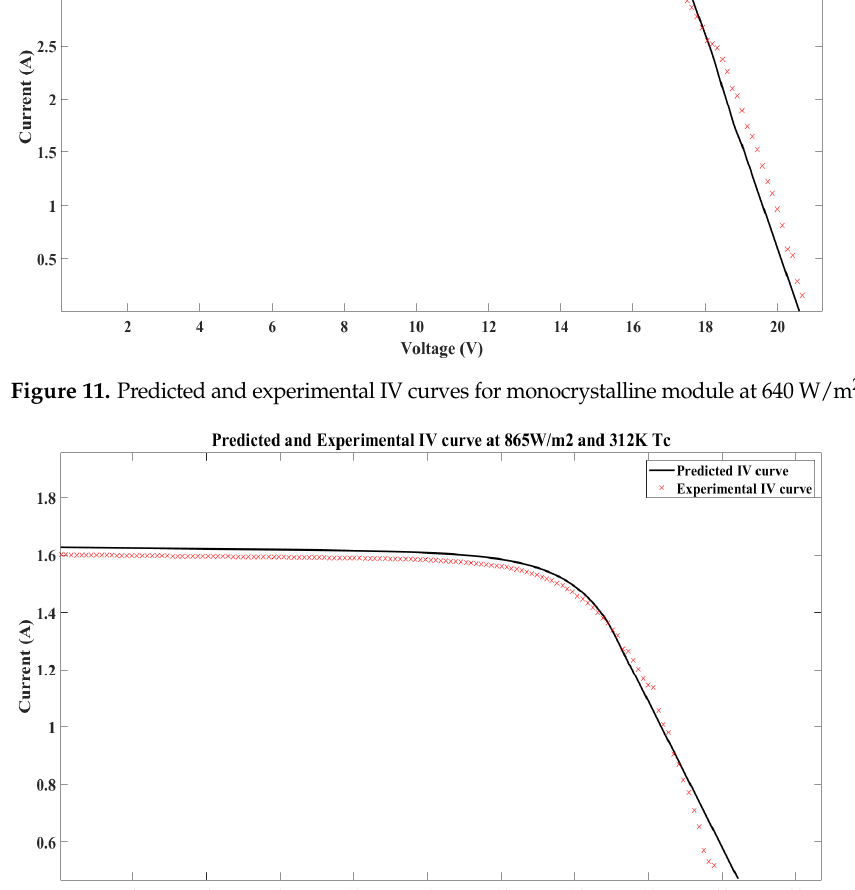
Figure 12. Predicted and experimental IV curves for flexible back-contact mono-module at 865 W/m 2 and 312K Tc.